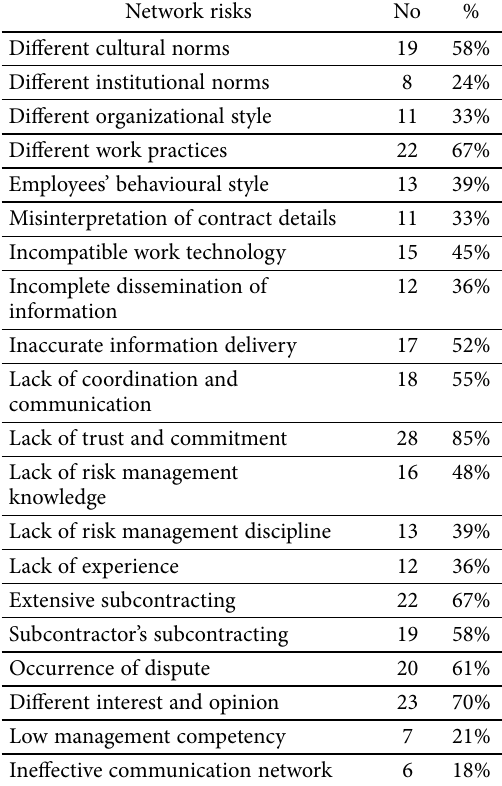
Table 2. Analysis results – network risks Network risks